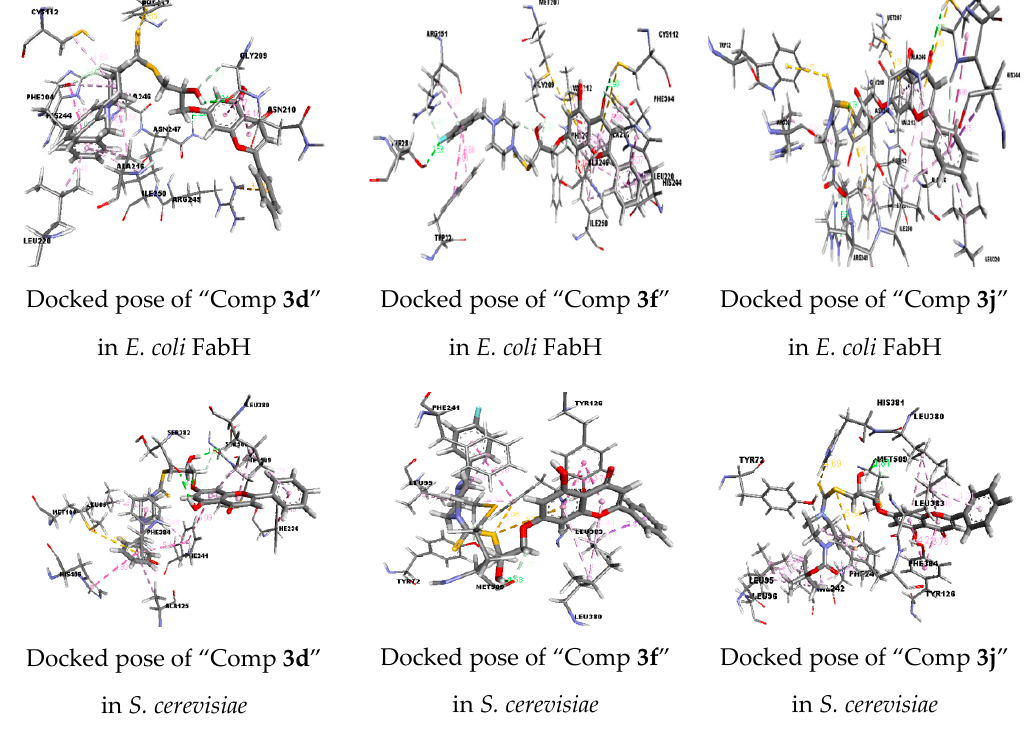
Figure 1. ( 3d , 3f , and 3j ) docked into the binding site of E. coli FabH ( 1HNJ ) enzyme and S. cerevisiae ( 5EQB ) with Discovery studio client 4.2.